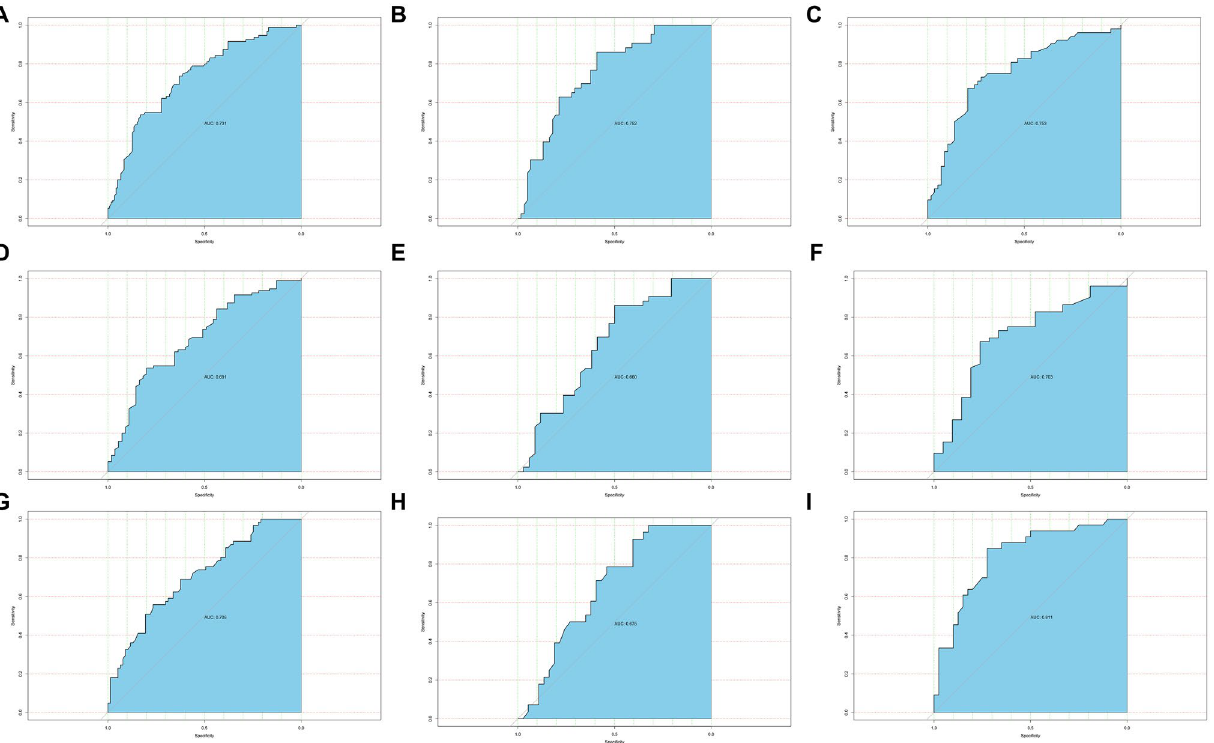
Figure 2. Predictive effect of the UA level. ( A – C ) respectively showed the results of ROC analysis, which indicated that the UA could significantly distinguish BD and UD at acute stage, in all subjects, in male subjects and in female subjects. ( D – F ) respectively showed the results of ROC analysis, which indicated that the UA could significantly distinguish BD-D and UD at acute stage, in all subjects, in male subjects and in female subjects. ( G – I ) respectively showed the results of ROC analysis, which indicated that the UA could significantly distinguish BD and UD at remission stage, in all subjects, in male subjects and in female subjects. BD, bipolar disorder; BD-D, bipolar depression; UD, unipolar depression; UA, uric